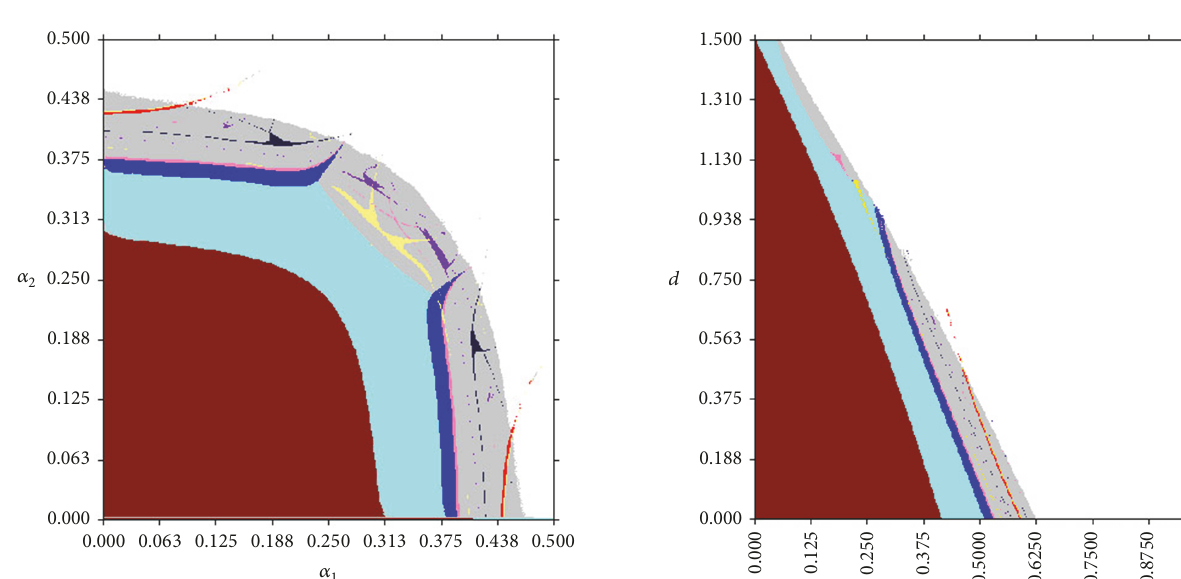
Figure 4: The 2-D bifurcation diagram of the system with (𝛼 1 ,𝛼 2 ) .